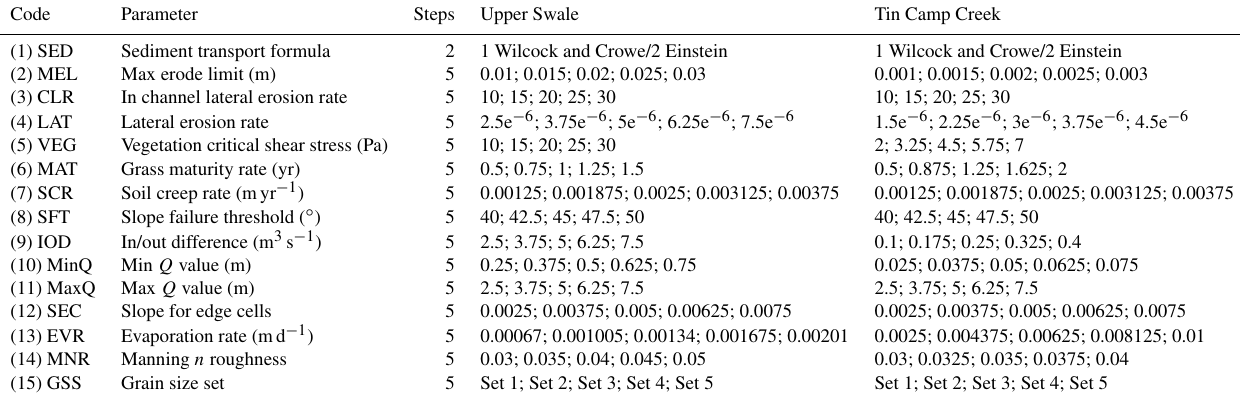
Table 1. User-defined parameters used and the min and max values for the two study catchments.